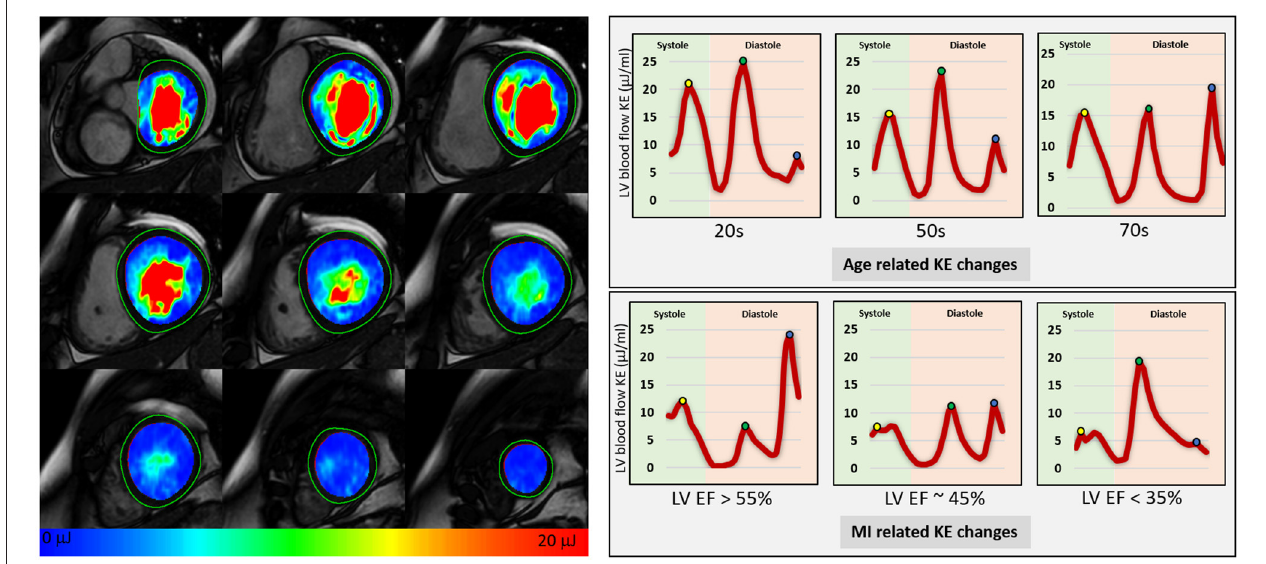
FIGURE 9 | Left ventricular blood flow kinetic energy mapping in healthy, ageing, and in patients with myocardial